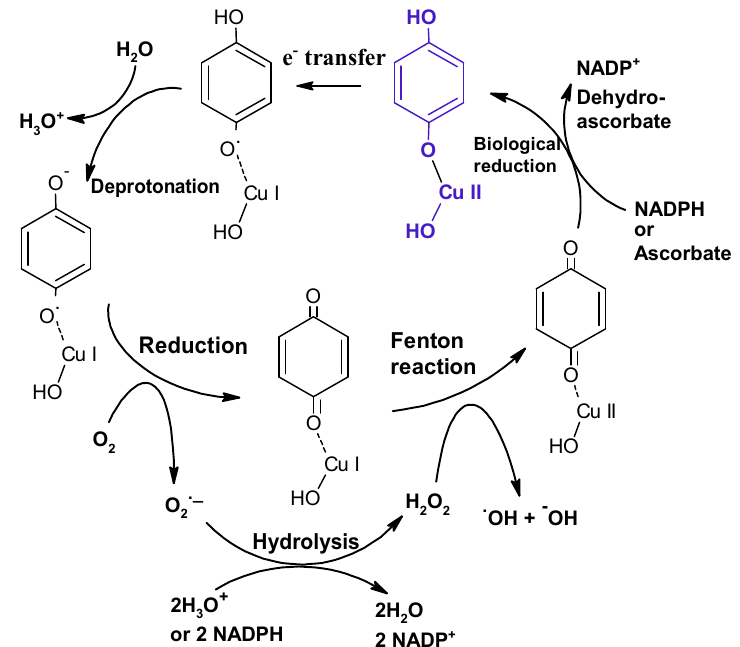
Figure 3. Proposed cycle for the generation of ROS by a pollutant-CuO particle system. The process begins when CuO is chemisorbed to the surface of the particle (Figure 2). For simplicity, in this example, hydroquinone is shown as an example of an organic pollutant. Beginning with the structure indicated in blue and working counter-clockwise, hydroquinone is adsorbed to the surface of the CuO-particle system and an electron is transferred from hydroquinone to Cu(II) to generate Cu(I) and semiquinone free radical. Following deprotonation of the other phenolic proton, an electron is transferred from the chemisorbed-radical compound to molecular O 2 to produce superoxide and a non-radical product. Finally, the superoxide is converted to H 2 O 2 in the presence of NADPH, ascorbate or thiols, all in high abundance on the lung surface. The resulting H 2 O 2 can undergo Fenton-type reactions with the chemisorbed Cu(I) to produce·OH, and can regenerate Cu(II) on the particle to complete an ROS-generating redox cycle.